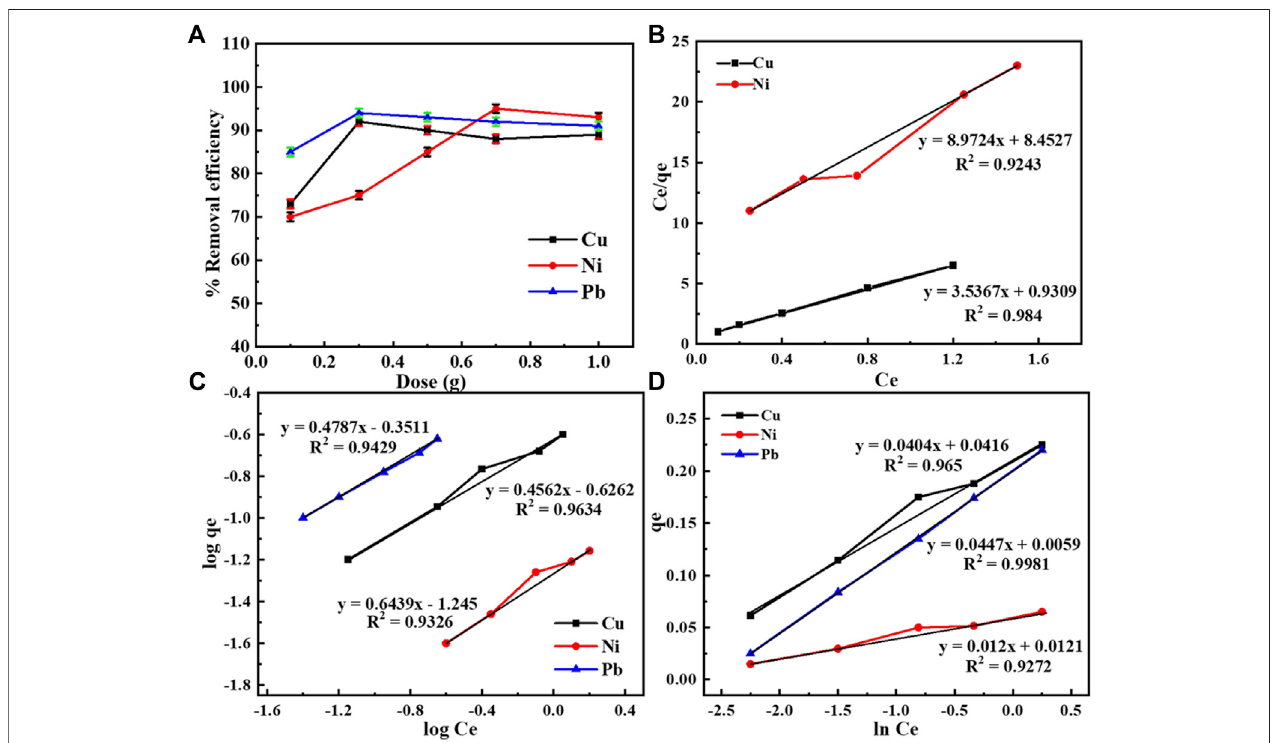
FIGURE 6 | (A) Removal ef fi ciency of Cu, Pb, and Ni by taking a different amount of composite. (B) Langmuir isotherms for Cu and Ni. (C) Freundlich isotherm for Pb, Cu, and Ni. (D) Temkin isotherm for Cu, Ni, and Pb.